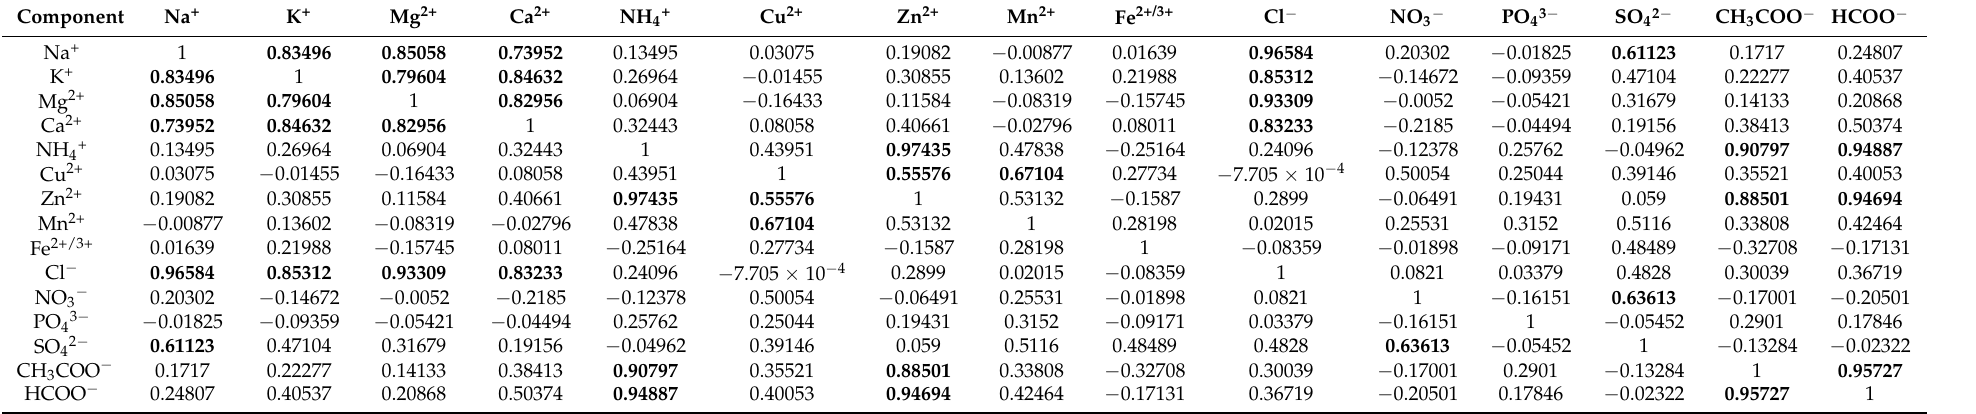
Table 5. Pearson correlation coefficients. The significant correlation coefficients at 0.05 level are shown in